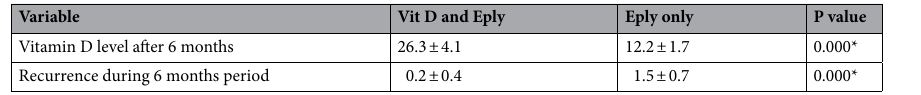
Table 2. Comparison between vitamin D level and recurrence rate after 6 months in group A and group B. * highly significant.